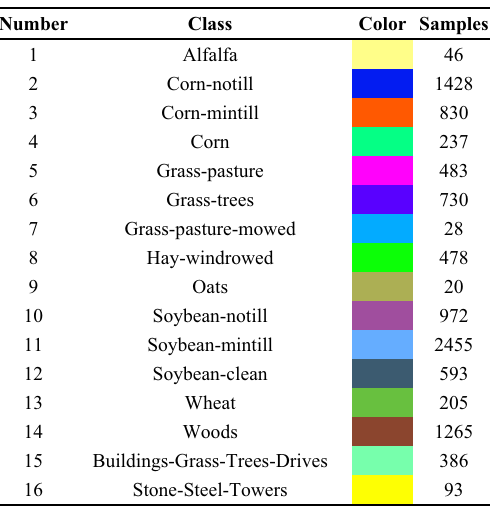
Table 2. Information of ground object types in Indian pines area.